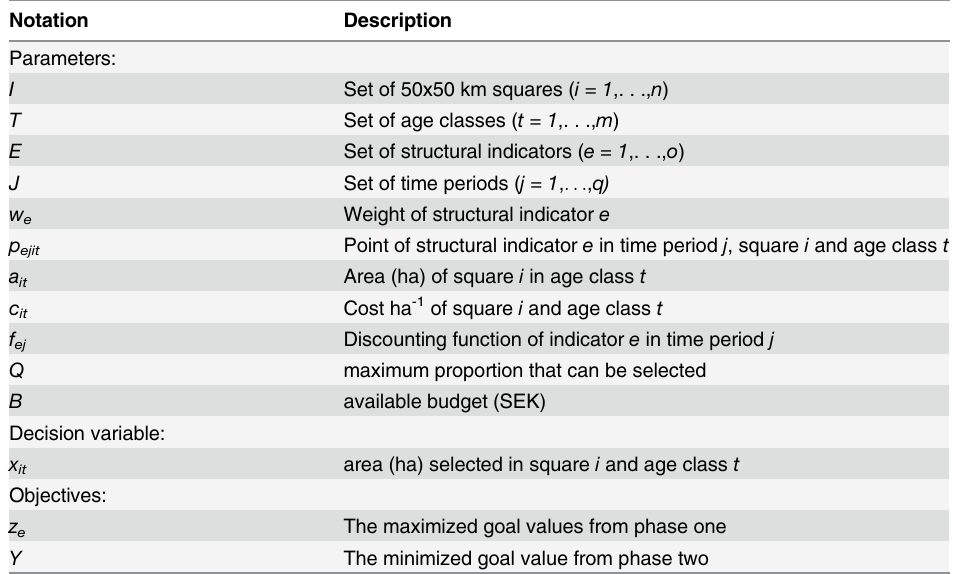
Table 2. Parameters and decision variables used in the reserve selection